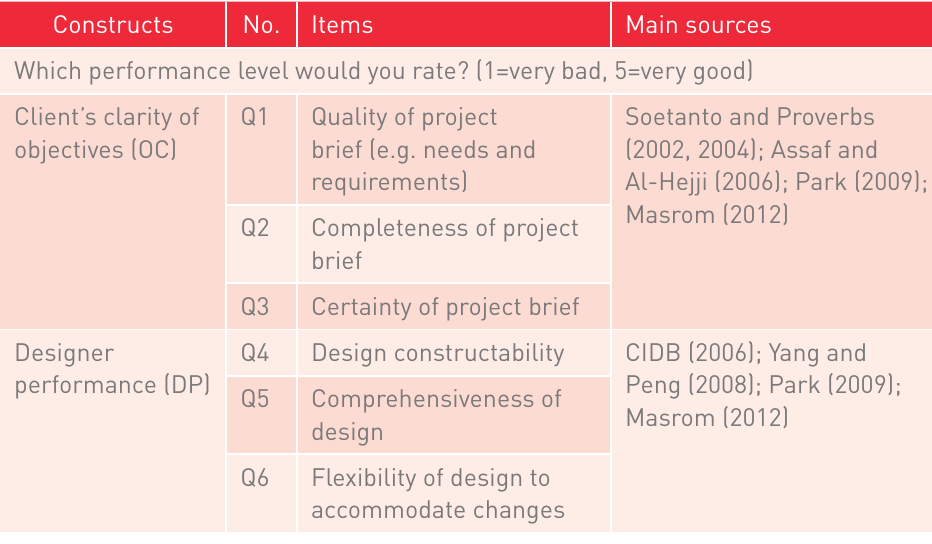
Measurement constructs and items Constructs No.